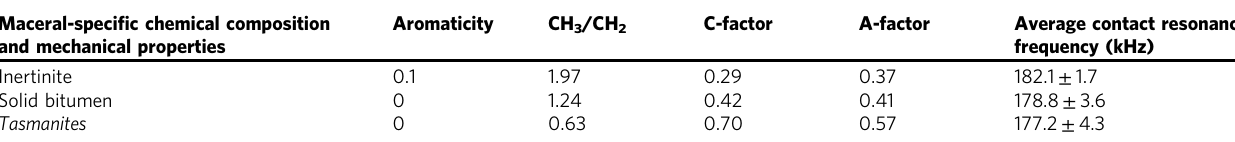
Table 2 IR ratios and mechanical stiffnesses computed from the average localized AFM-IR spectra from inertinite, solid bitumen, and Tasmanites in immature New Albany